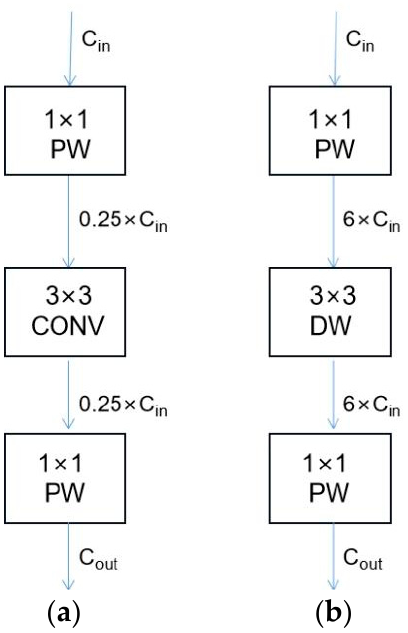
Figure 3. Structure diagram of MobileNetv2.